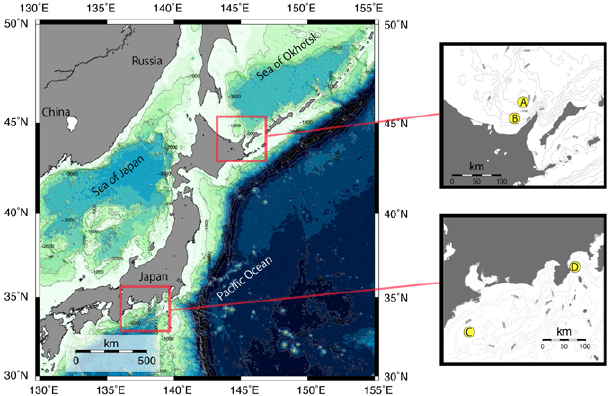
Fig. 1. Map of the study area and sampling sites. Site A (44 ◦ 10 0 N, 144 ◦ 45 0 E; water depth 870m) and site B (44 ◦ 31 0 N, 145 ◦ 00 0 E; wa- ter depth 1208m), Sea of Okhotsk off Abashiri; site C (33 ◦ 42 0 N, 137 ◦ 05 0 E; water depth 1881m), Nankai Trough off Kumano; site D (35 ◦ 00 0 N, 139 ◦ 14 0 E; water depth 1182m), Sagami